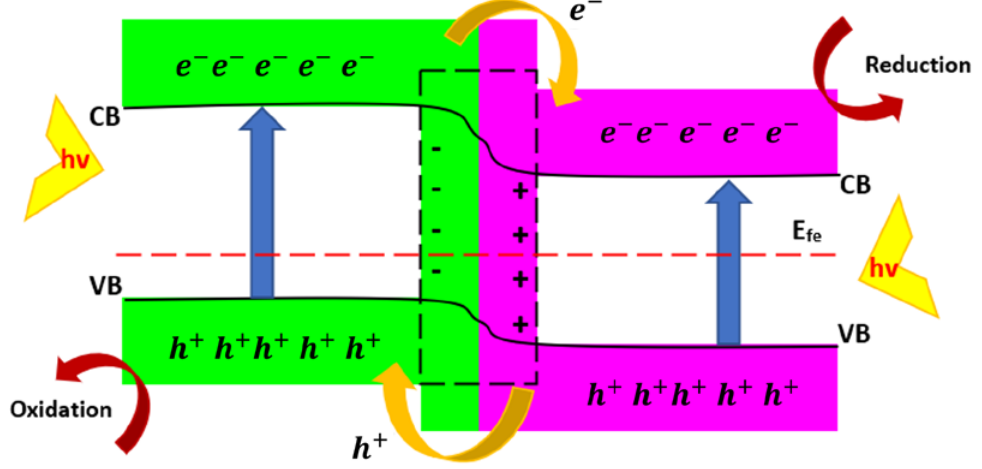
Figure 12. A simplified illustration of a p–n heterojunction construction.